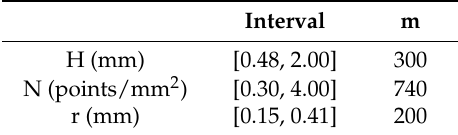
Table 3. Intervals for variables and m-values used for